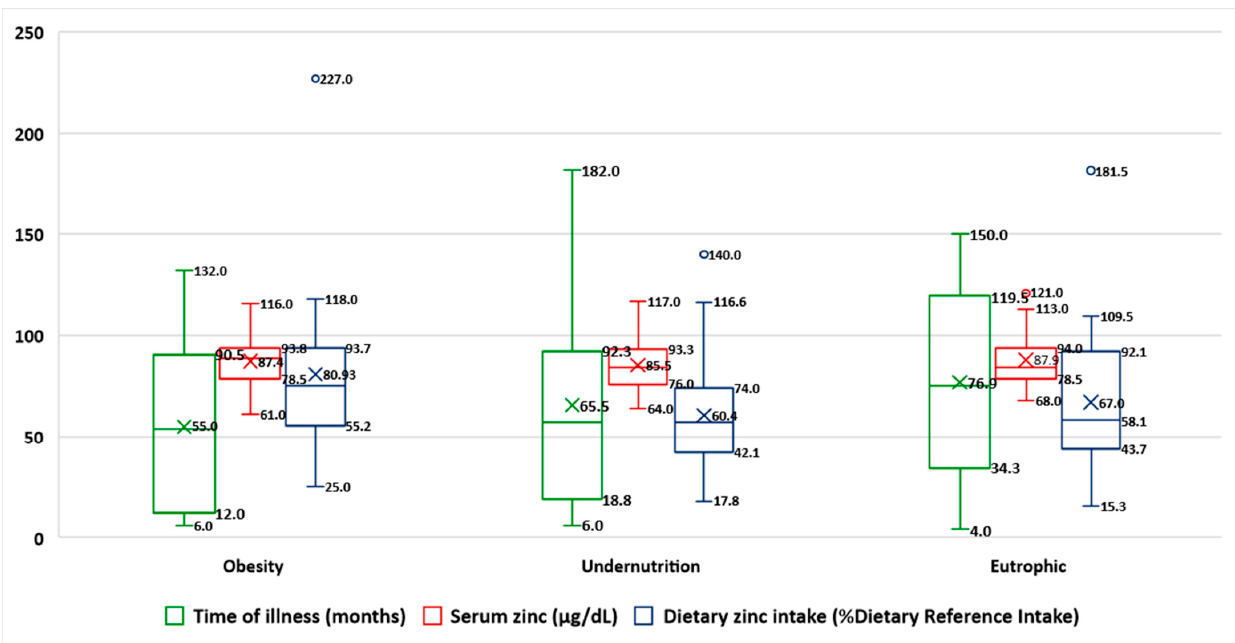
Figure 2. Median, mean, and quartiles of the time of illness, serum zinc, and dietary zinc intake in the whole series by nutritional status via body mass index ( N = 78).